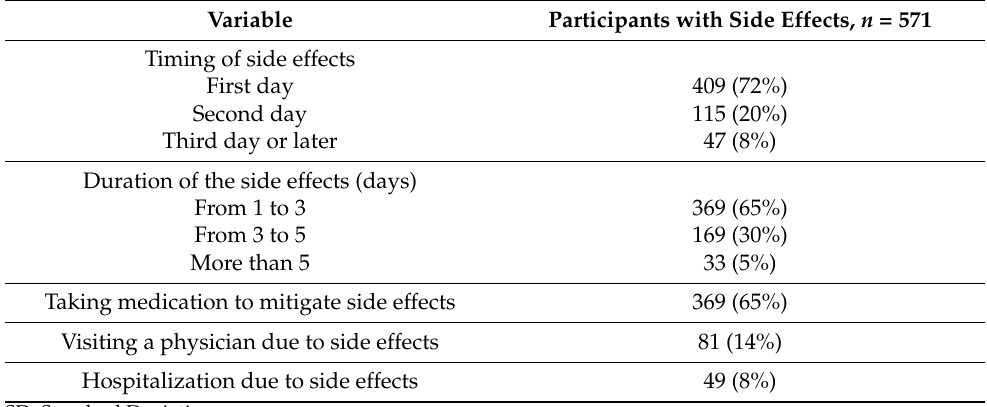
Table 4. General characteristics of the participants presented with side effects after COVID-19 vaccination.